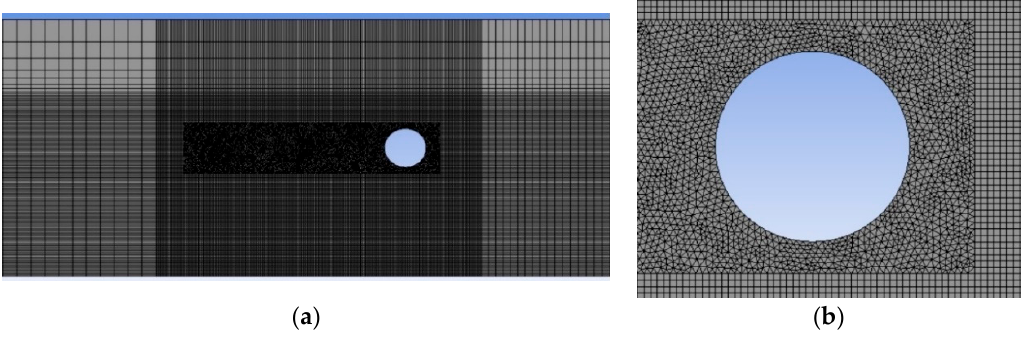
Figure 3. ( a ) The computational mesh of the solution domain; ( b ) an enlarged view around the cylinder surface.